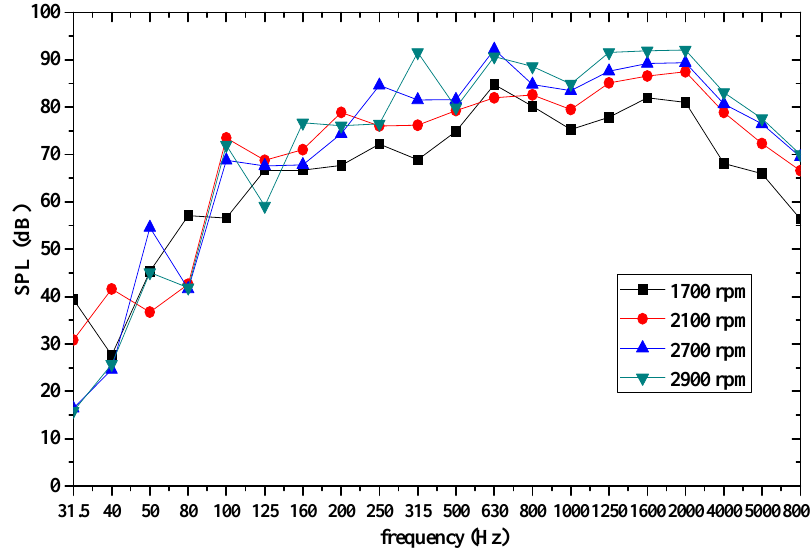
Figure 4. Changes in SPL in a wide frequency range under various rotational speeds